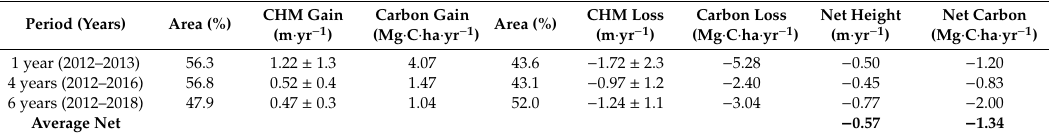
Table 1. Comparison of the estimated gain and losses in carbon and tree height for all the time intervals analyzed. Percentage of areas of gain and loss are provided. Net height and net carbon are also presented for each period.